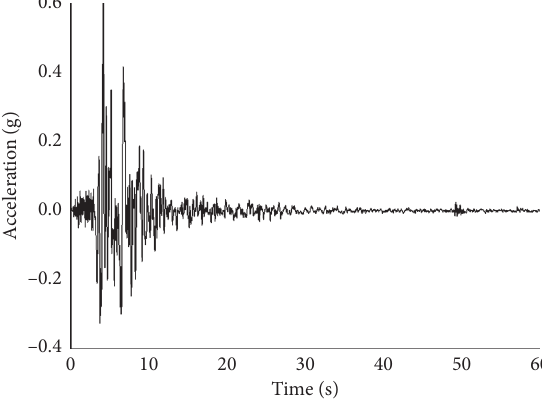
Figure 4: Time history of Northridge